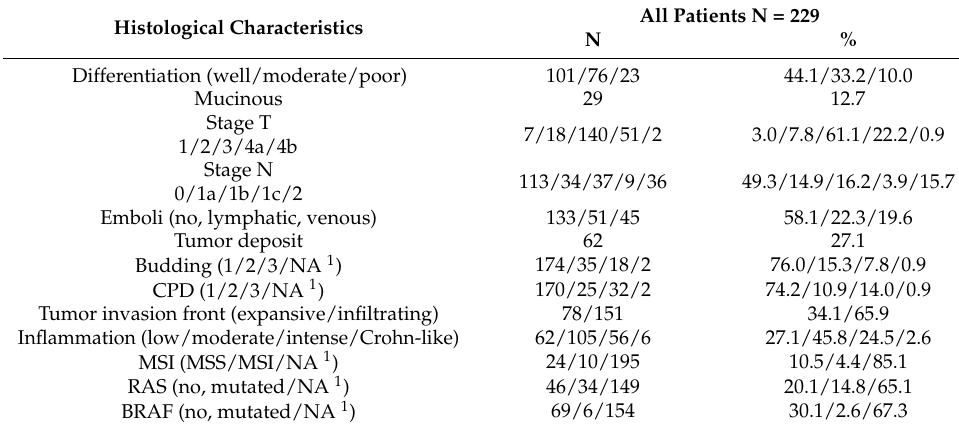
Table 2. Histological characteristics of the cohort.